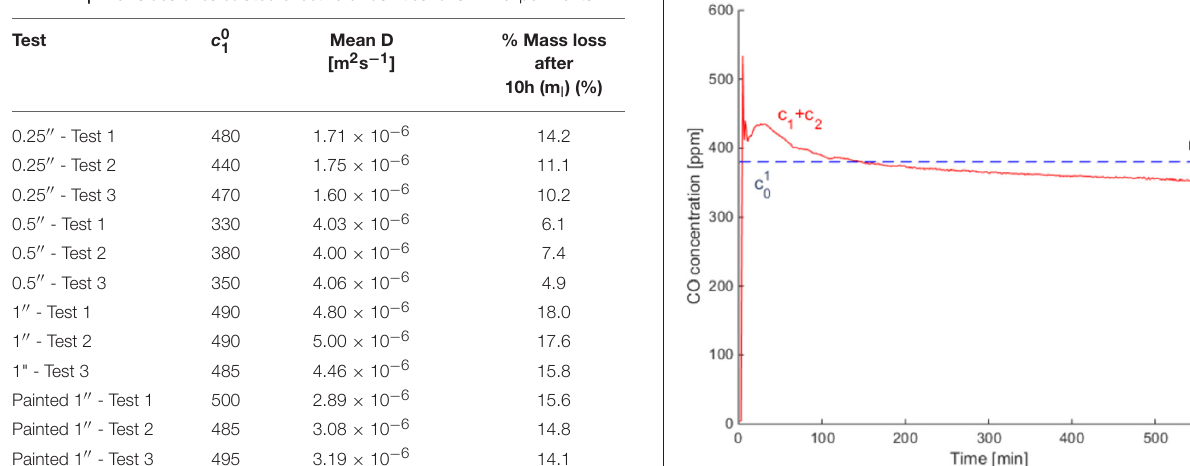
TABLE 1 | The values of calculated effective diffusivities for all 12 experiments.